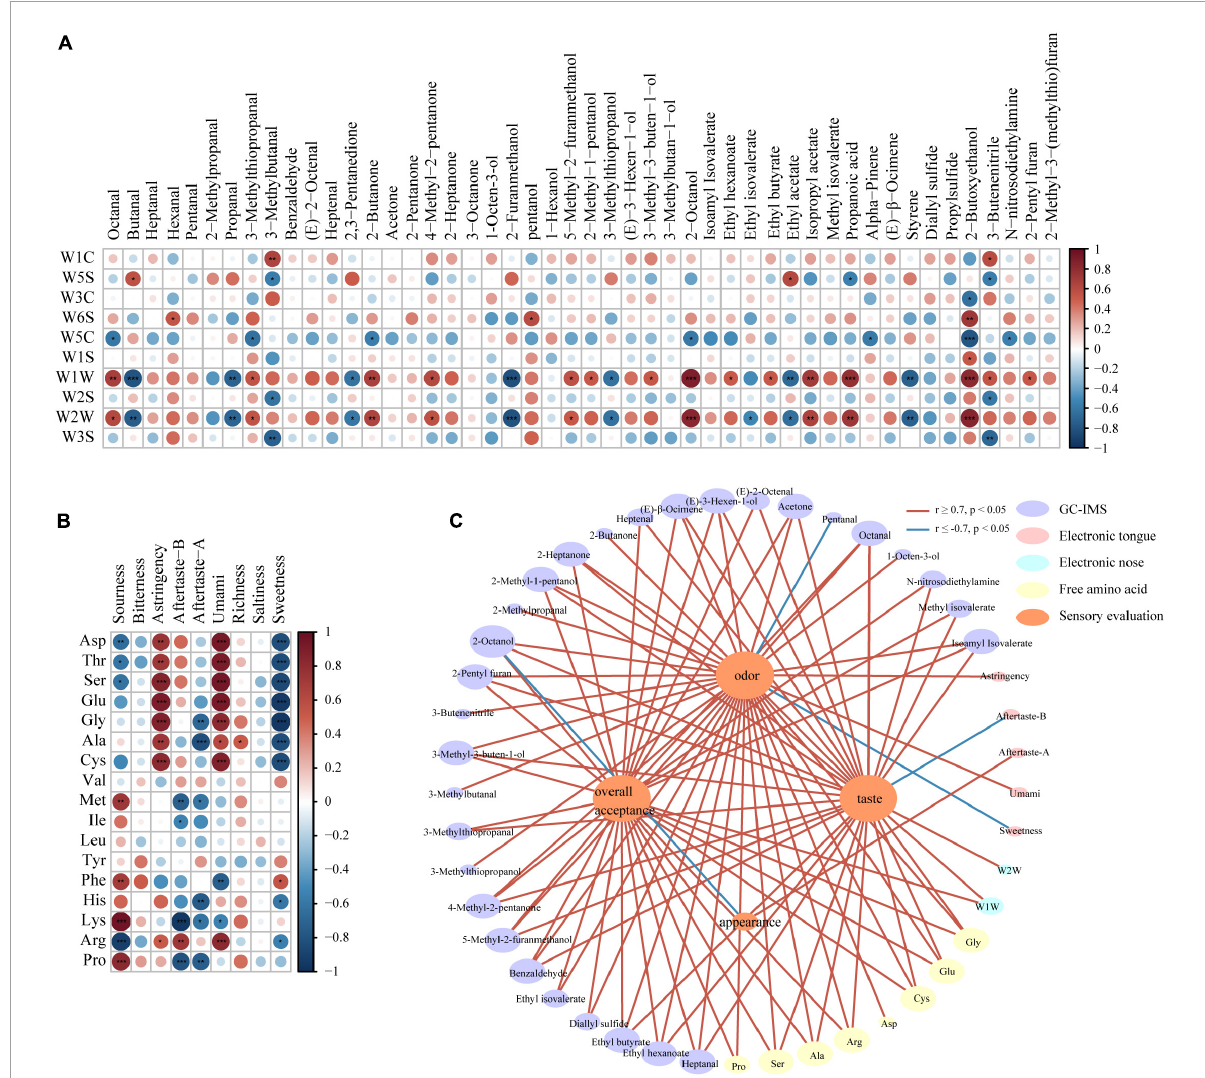
FIGURE5 Correlation analysis: (A) Between volatile compounds with e-nose results and (B) between free amino acids with e-tongue results (*0.01 < P < 0.05, **0.001 < P < 0.01; *** P < 0.001). (C) Correlation networks between volatile compounds, e-nose results, free amino acids, e-tongue results with sensory scores, based on Pearson correlation coefficients (| r | > 0.7, P < 0.05) (Red represents positive correlations, and blue represents negative